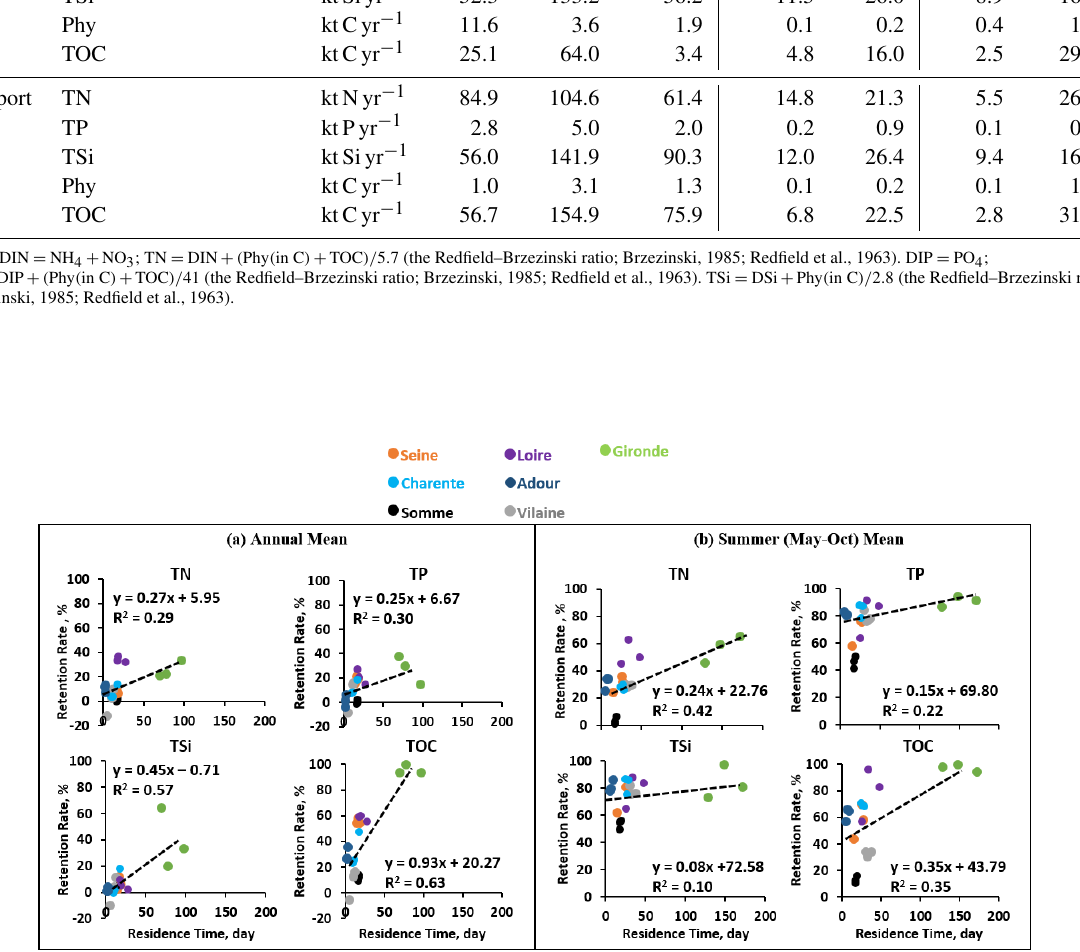
Biogeosciences, 19, 931–955,